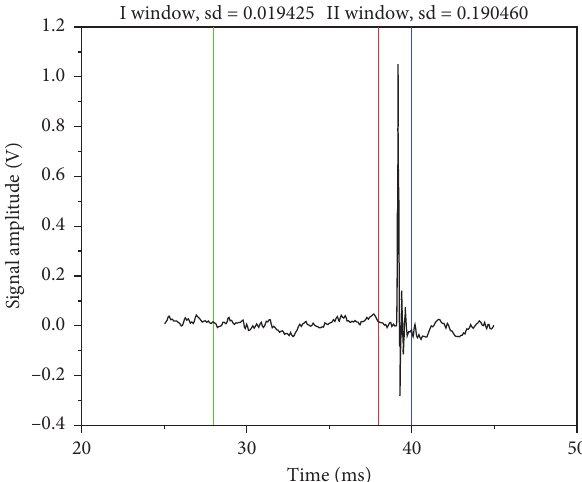
Figure 9: Signal excerpt with two adjacent windows marked. Two Figure 6: Single hit of triticale. windows capture the moment of detection in real time. The window on the left following the window on the right observes the regular signal with the noise, while in the right window it is possible to observe an impact of the type shown in Figure 4. Above both windows, SD values for both windows are presented.